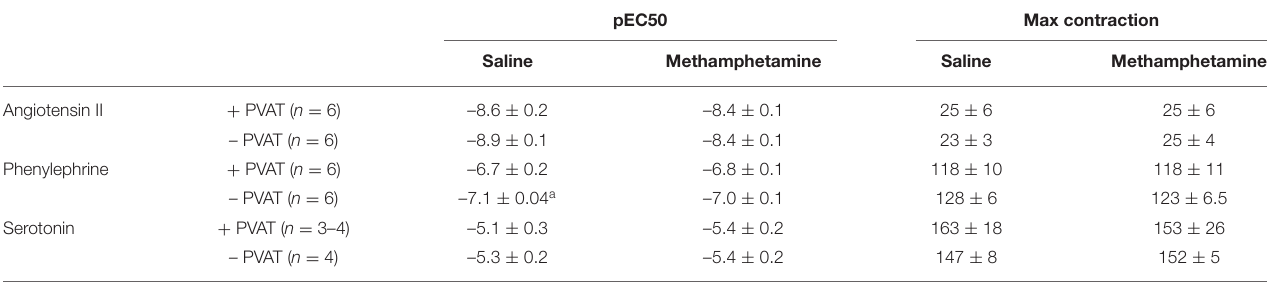
TABLE 4 | Angiotensin II, phenylephrine, and serotonin-induced contractile responses in aortas isolated from adult female rats that were exposed to fetal saline or methamphetamine (5 mg/kg/day) throughout the gestational